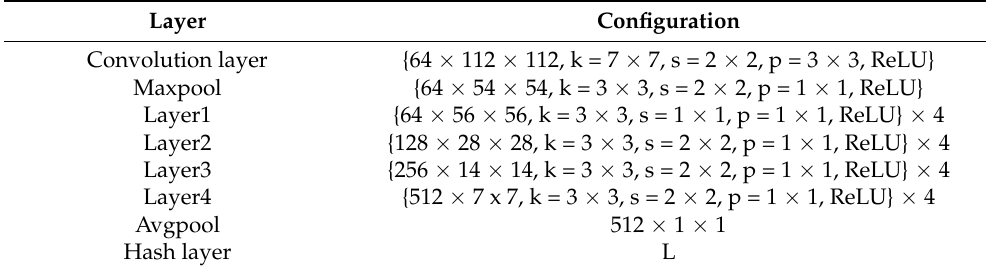
Table 1. Backbone network settings for